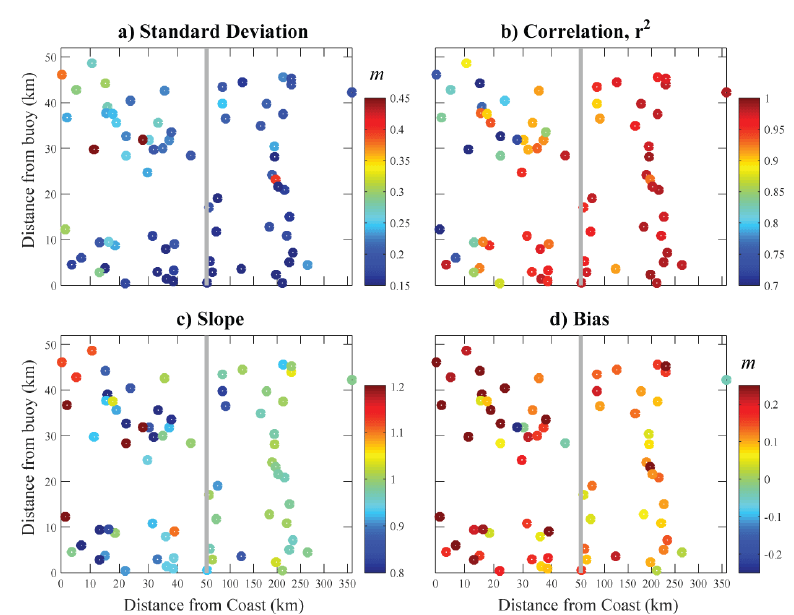
Figure 10. Assessment using the median of the estimates from the Jason-3 retrackers, showing the worse performance in general closer to the coast. ( a ) Standard deviation (m); ( b ) Correlation, r 2 ; ( c ) Slope; and, ( d ) Bias. (All plots have a bilinear x-axis to focus on the behaviour for those within 50 km of the coast).